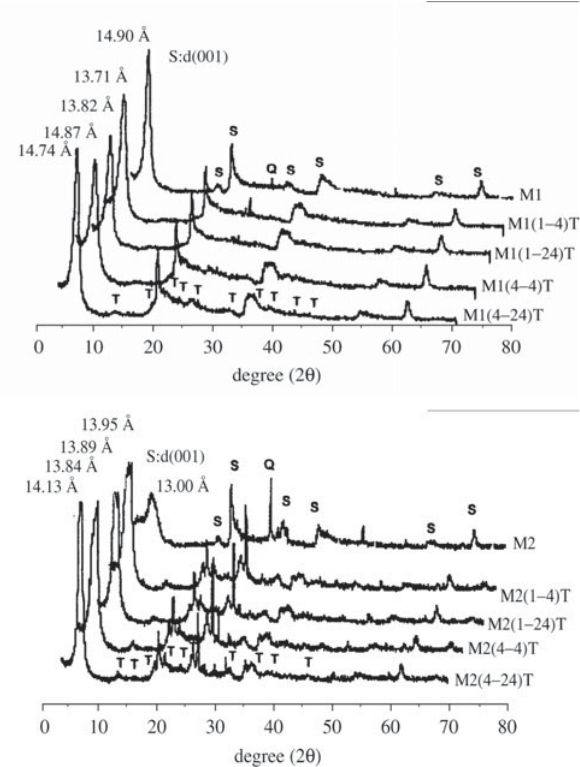
Figure 2. X-ray diffraction: a) TMA-M1 serie; b) TMA-M2 serie. T: tetramethylammonium specie; S: smectite; Q: